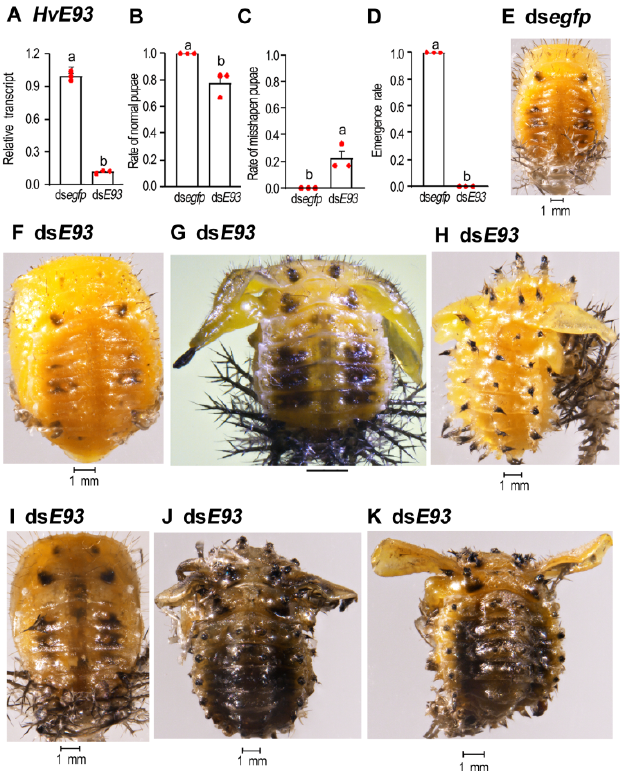
Figure 6. Knockdown of both HvE93 isoforms in the prepupae influences pupation and adult emergence in Henosepilachna vigintioctopunctata . Around 500 ng of ds E93 or ds egfp (0.1 μ L) was injected into the newly formed prepupae. One day after injection, the expression level (2 − ∆∆ CT value) of HvE93 was measured ( A ). Rates of normal and deformed pupae ( B , C ) and emergence rate ( D ) were recorded during a 3-week trial period. Different letters above the columns (means ± SE) show a significant difference at p < 0.05 using an independent sample t -test. Two defective phenotypes were noted: normal pupae ( F ) and wing-stretched pupae with both pupal spines and larval scoli on the cuticle ( G , H ), compared to the control pupa ( E ). The treated pupae become darkened and dried ( I – K ). No treated pupae emerge as adults ( D ).